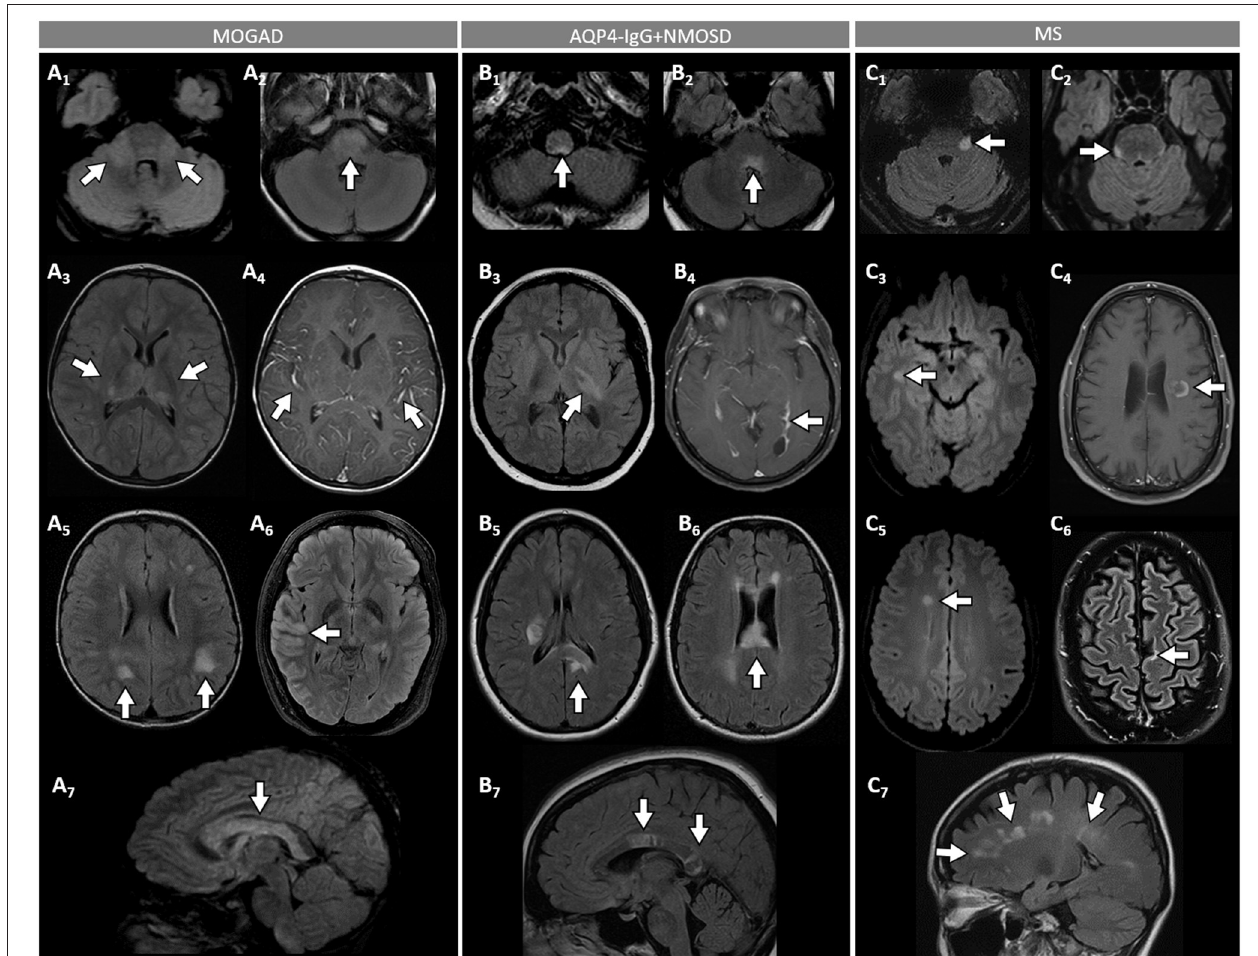
FIGURE 3 | Brain MRI features in patients with MOGAD, AQP4-IgG + NMOSD, and MS. [ (A) : MOGAD] T2-hyperintense lesions on axial FLAIR images diffusely involving the middle cerebellar peduncles bilaterally (A 1 , arrows), pons (A 2 , arrow), and bilateral thalami (A 3 , arrows); while extensive leptomeningeal enhancement is noted on axial T1-post gadolinium images (A 4 , arrows); axial FLAIR images reveal T2-hyperintensities that are poorly marginated or “fluffy” in the hemispheric white matter (A 5 , arrows), with thickening of the right temporal-parietal cortex (A 6 , arrow), and diffuse involvement of the corpus callosum on sagittal view (A 7, arrow). [ (B) : AQP4-IgG + NMOSD] Axial FLAIR images show T2-hyperintense lesions in the area postrema (B 1 , arrow), dorsal pons adjacent to the 4th ventricle (B 2 , arrow), and left corticospinal tract at level of the internal capsule (B 3 , arrow); axial T1-post gadolinium image reveals linear ependymal enhancement in the posterior horn of the left lateral ventricle (B 4 , arrow); FLAIR images reveal T2-hyperintense lesions involving the splenium of the corpus callosum (B 5 , arrow, axial view) and a diffuse “marble pattern” hyperintensity of the corpus callosum (B 6 , axial view, arrow, and B 7 , sagittal view, arrows). [ (C) : MS] Axial FLAIR images reveal small foci of T2-hyperintensity involving the pons at the emergence of the left trigeminal nerve (C 1 , arrow), and on its ventral-right surface (C 2 , arrow); axial FLAIR images reveal periventricular T2-hyperintense lesions in the inferior temporal pole (C3, arrow) and frontal horn with an ovoid appearance (C5, arrow); on axial T1-post gadolinium images an incomplete ring enhancing white matter lesion is shown (C 4 , arrow); FLAIR images reveal a juxtacortical T2-hyperintense lesion (C 6 , axial view, arrow) and Dawson’s fingers T2-hyperintense lesions (C 7, sagittal view, arrows). MOGAD, myelin oligodendrocyte glycoprotein antibody-associated disease; AQP4-IgG +